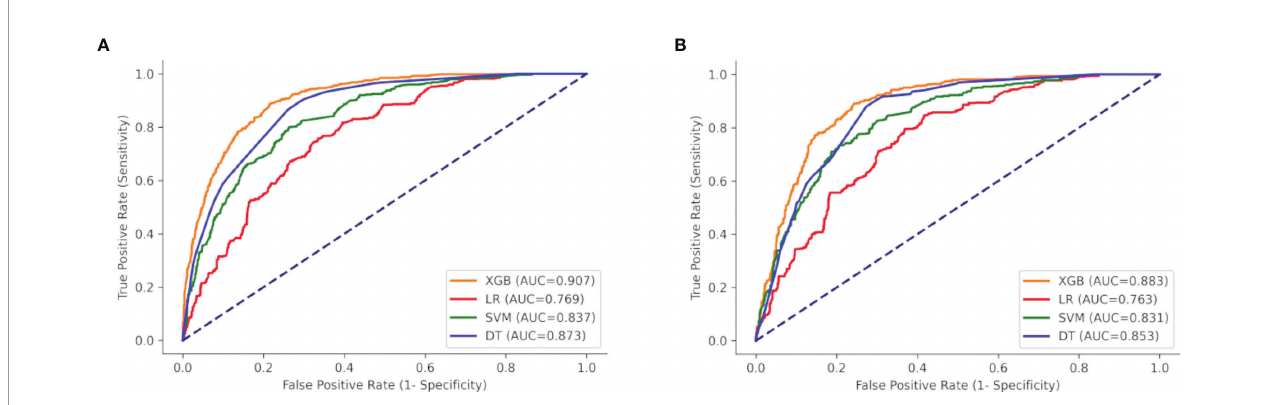
FIGURE 5 | ROC curves of the four models: XGB, SVM, DT, and LR. (A) Training set, and (B) test set. XGBoost, extreme gradient boosting; SVM, support vector machine; DT, decision tree; LR, multivariate